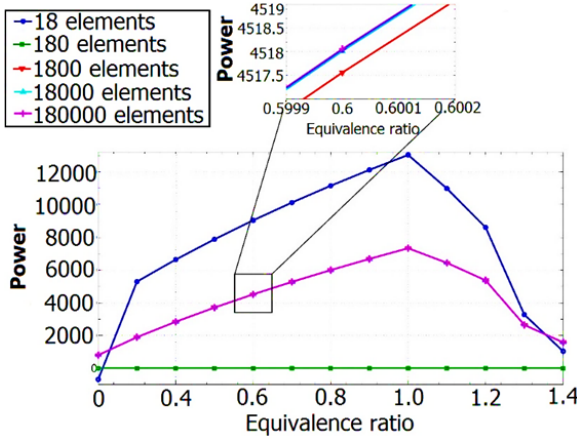
Figure 3. Variation in the power with the number of equilibrium states provided using the